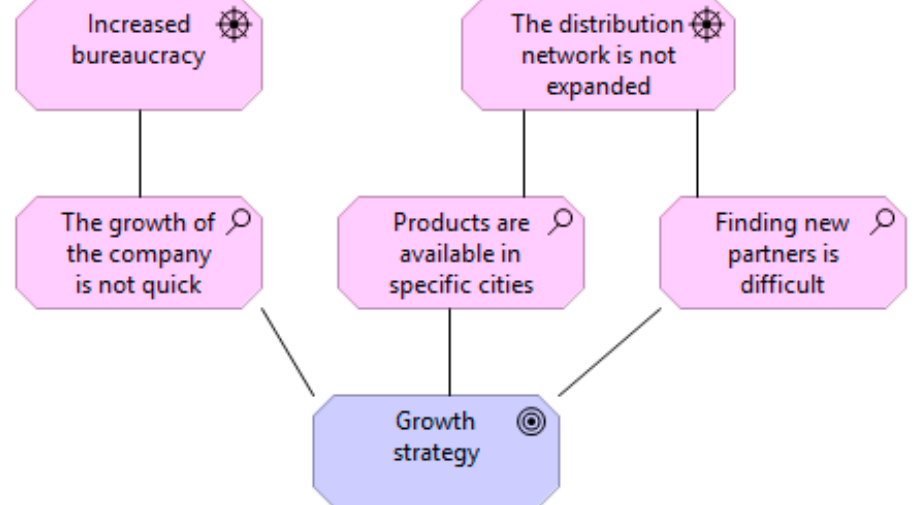
Figure 11. Formulation of the business strategy, based on drivers and assessments.